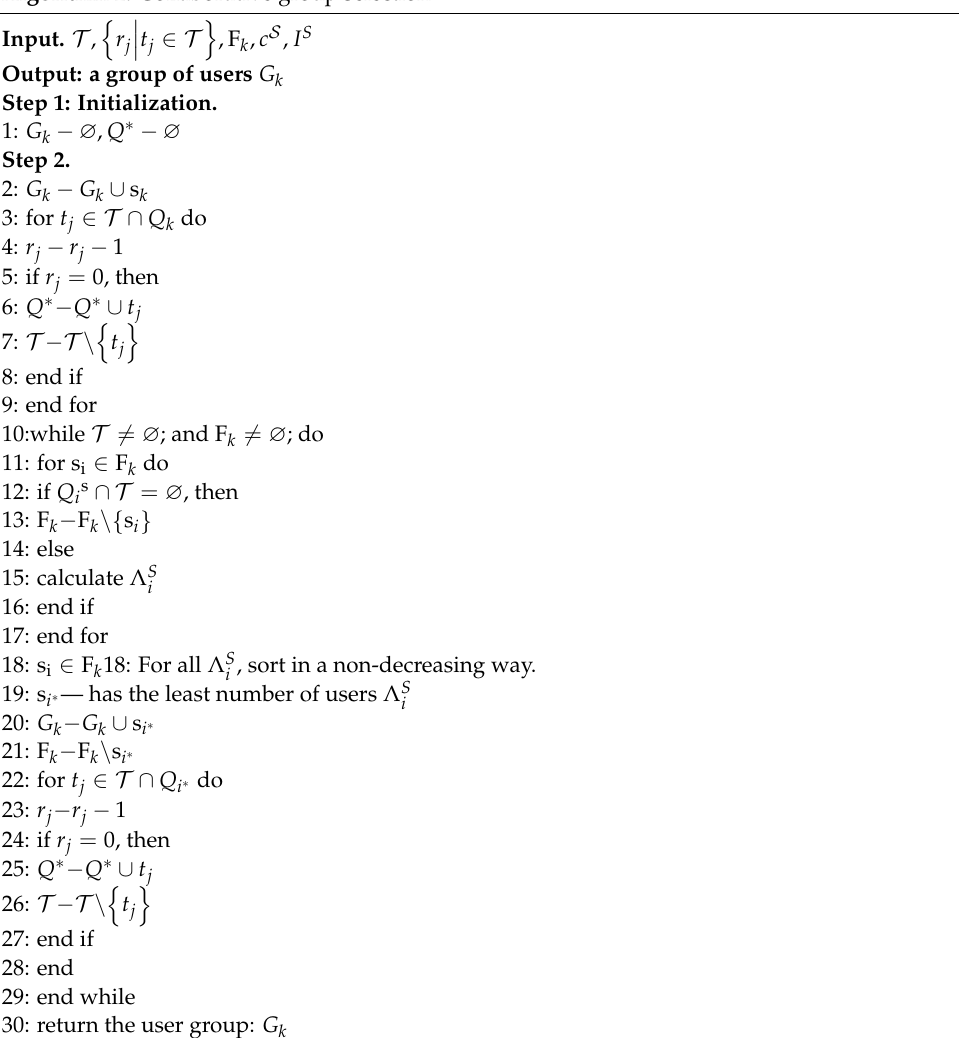
Algorithm 2: Collaborative group